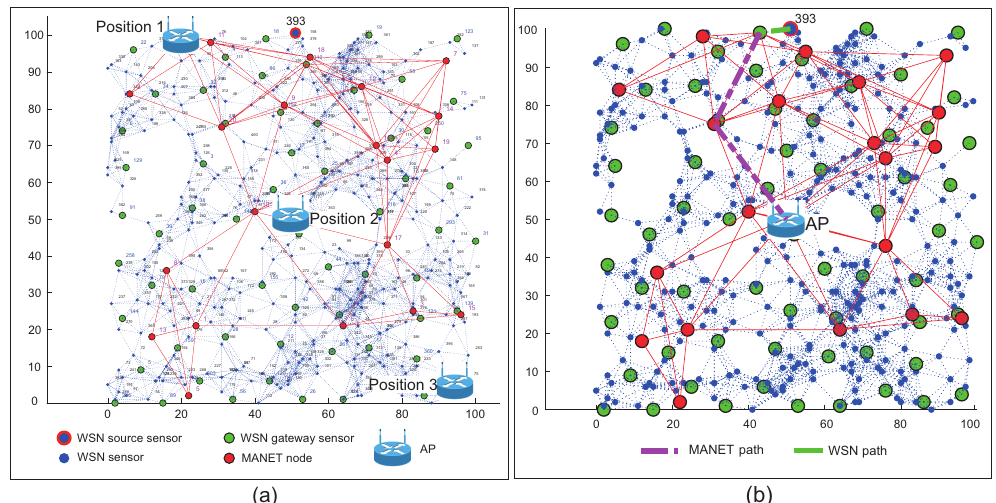
Figure 15. ( a ) Example of simulation scenario 1 with all positions of AP for WSN-MANET network. ( b ) Example of optimal routing path from WSN-MANET source sensor to AP deployed in Position 2 (in the middle of the simulation area).